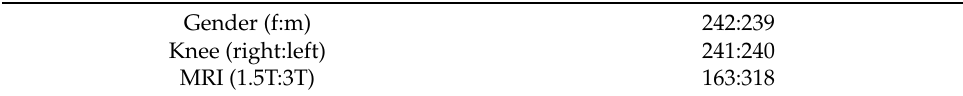
Table 3. Table 2. Binary variables distribution.